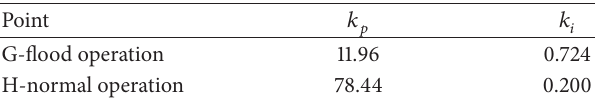
Table 2: Pairs of gains selected for carrying out simulations. Point